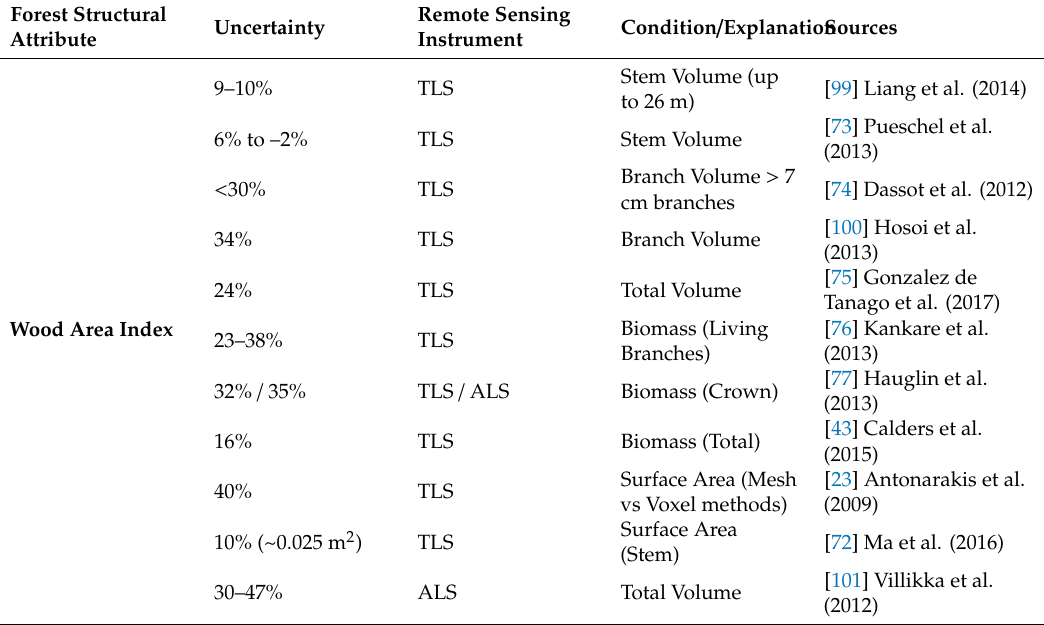
Table 2. Uncertainty in estimates of deriving leaf area index (LAI) and wood area index (WAI) obtained in previous studies using various remote sensing instruments and